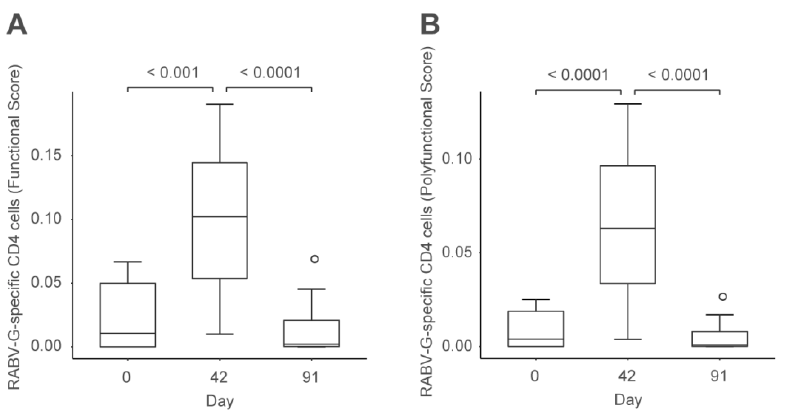
Figure 3 . Cellular immune responses in human volunteers to intradermal injection of 80 μ g mRNA (adapted from reference [34]). Intracellular cytokine staining of RABV-G-specific CD4+ T cells were analyzed using COMPASS and summarized as functionality ( A ) or polyfunctionality ( B ) scores. Boxes depict median values and IQRs, and whiskers extend from the hinge to the highest or lowest value within 1.5 × IQR of the respective hinge. N = 21 for days 0 and 42 and n = 15 for day 91.